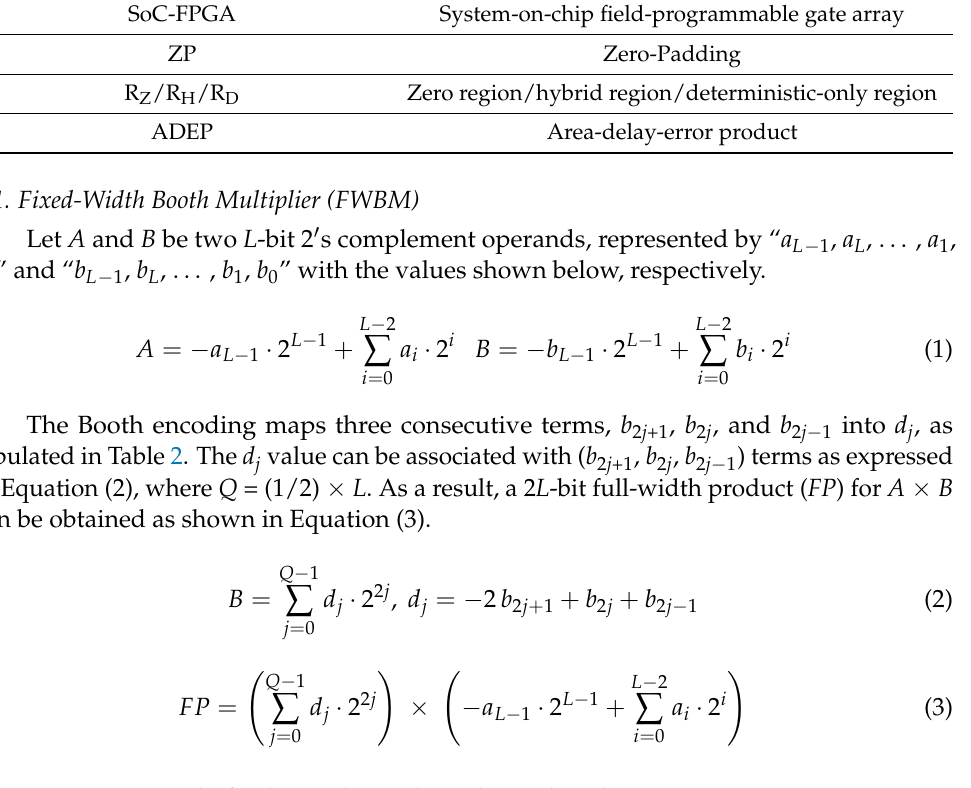
Table 2. Mapping results for the Booth encoder and partial